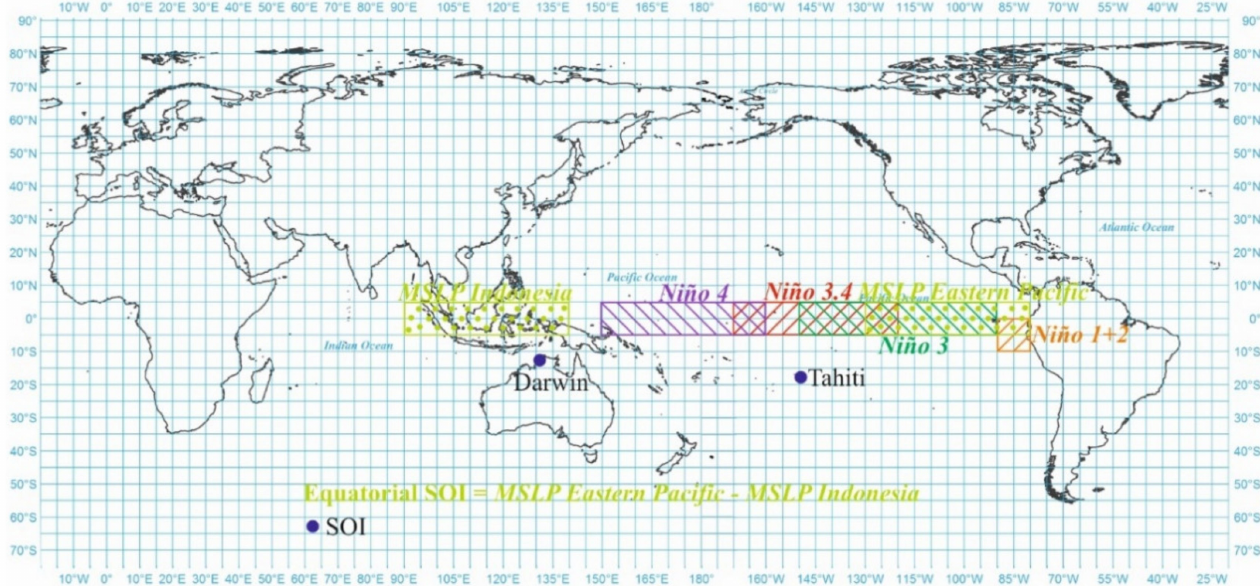
Figure 9. Location of areas for which different ENSO indices are